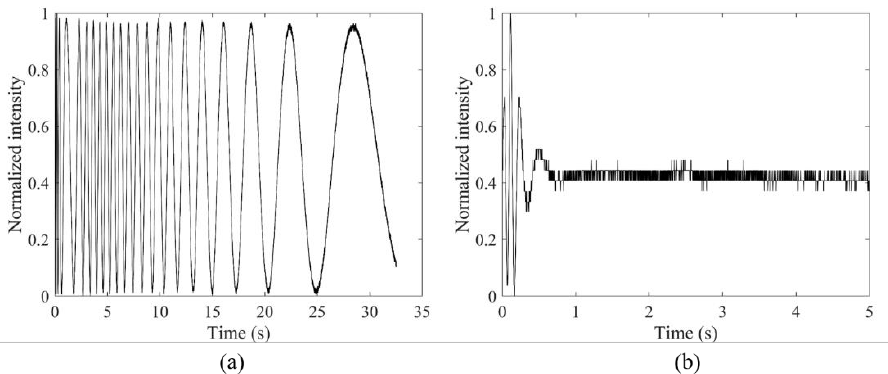
Figure 3. Interference light intensity variation with the relaxation time. t = 0 is the moment when the LC cell driving voltage 𝑉 m = 5 V is turned off. ( a ) The 1053 nm DFB fiber laser; ( b ) the halogen light.